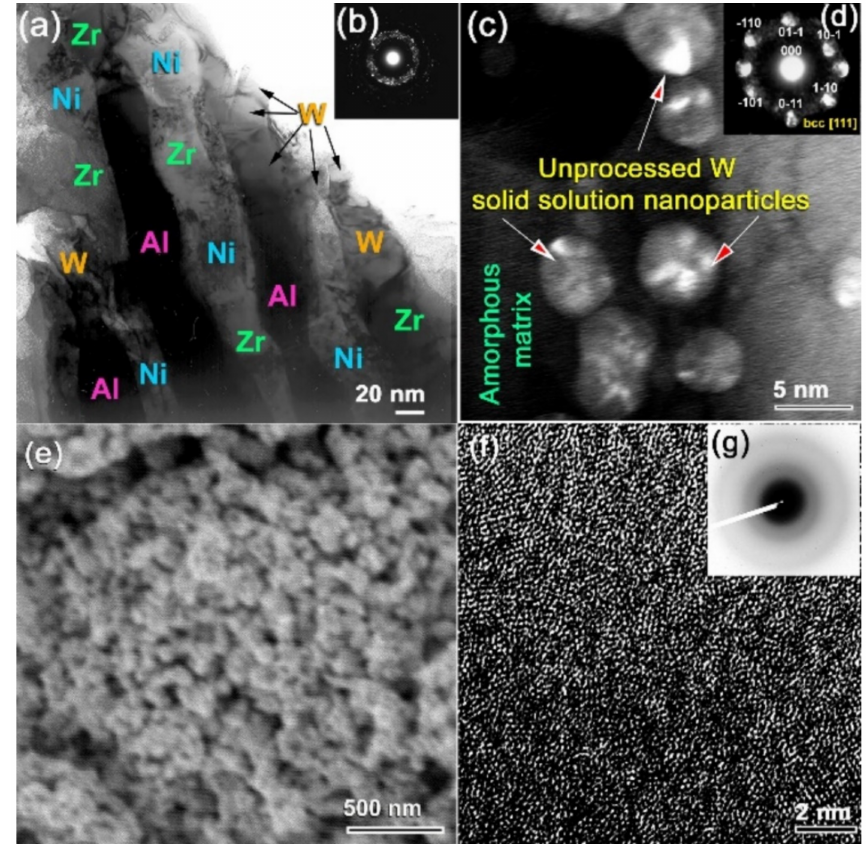
Figure 4. ( a , b ), and ( c , d ) show the FE-HRTEM images, and corresponding selected area diffraction patterns (SADPs) of the powders obtained after CR for 100 passes and CR for 100 passes followed by 25 h MA, respectively. ( e ) FE-SEM image of the powders CR for milling for 50 h after 100 passes of CR. The FE-HRTEM image and its related nanobeam diffraction pattern (NBDP) are presented in ( f , g ),